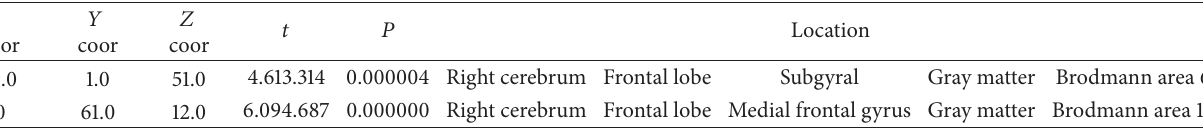
Figure 9: Pre- and posttraining differences in the motor imagery task. Table 3: Talairach coordinates of activations in the motor imagery